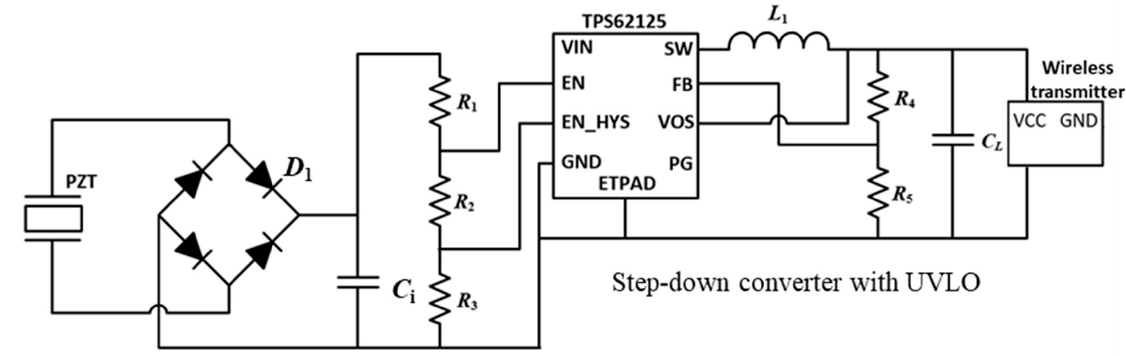
Figure 7. Schematic of the wireless communication circuit with a step-down converter.